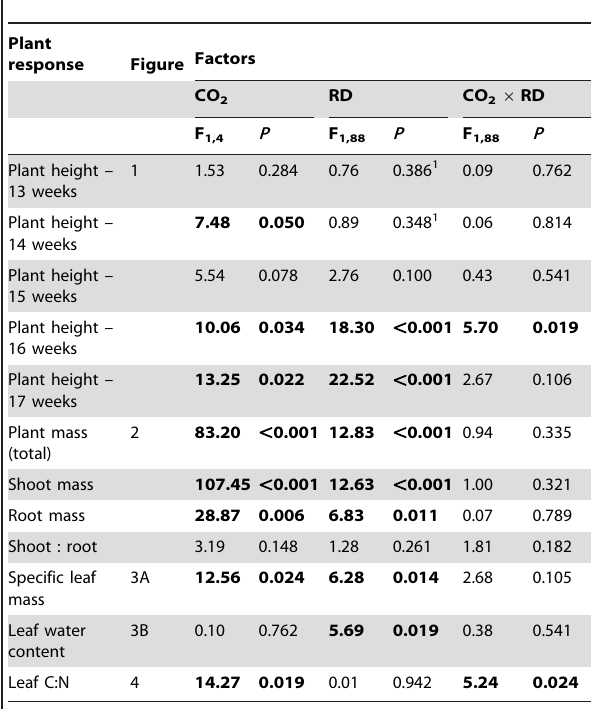
Table 1. Results of ANOVA tests of plant responses to aCO 2 and eCO 2 and root damaging insects (RD) relating to Figs. 1–